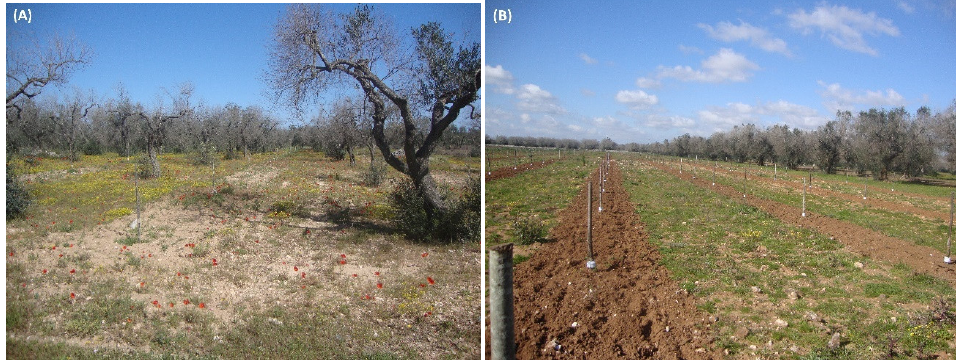
Figure 12. Attempts to replant olive groves in Salento with Leccino in between declining trees ( A ) or in place of a previous olive grove ( B ). The failure of the young trees is evident. Note that plowing soil along the row facilitates deeper infiltration of rainfall ( B ).